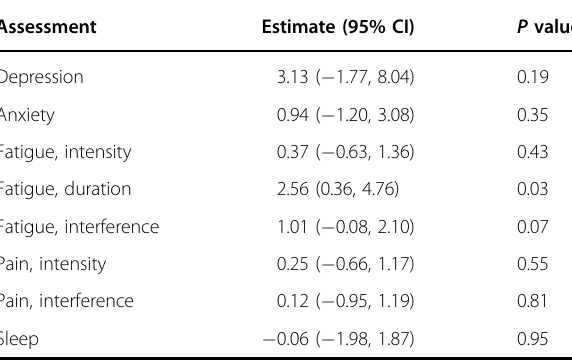
Table 4 Effect of presence of aGVHD (grades II – IV) compared to those without aGVHD at same time point, based on propensity-weighted a models for quality of life patient-reported outcomes after adjusting for baseline values and